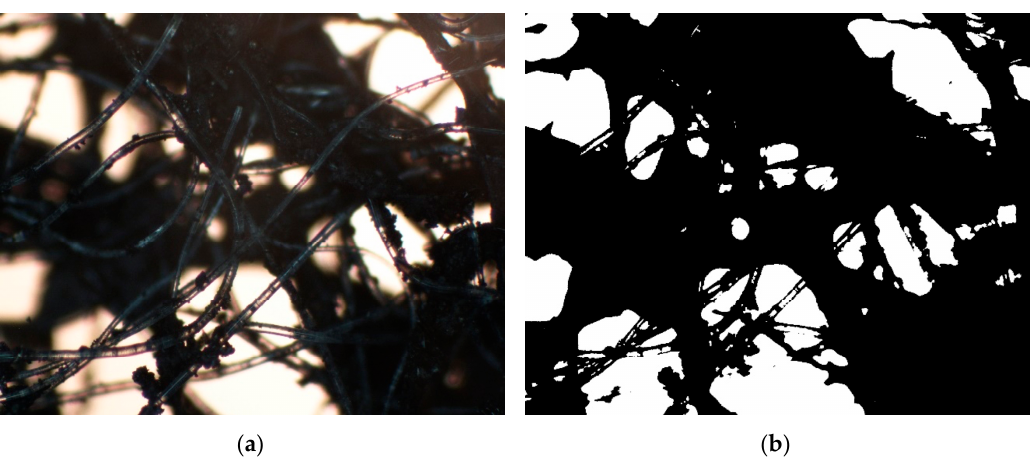
Figure 1. Raw optical microscope image ( a ) and grayscale representation ( b ) of activated-carbon-loaded nonwoven (AC-NW) sample.